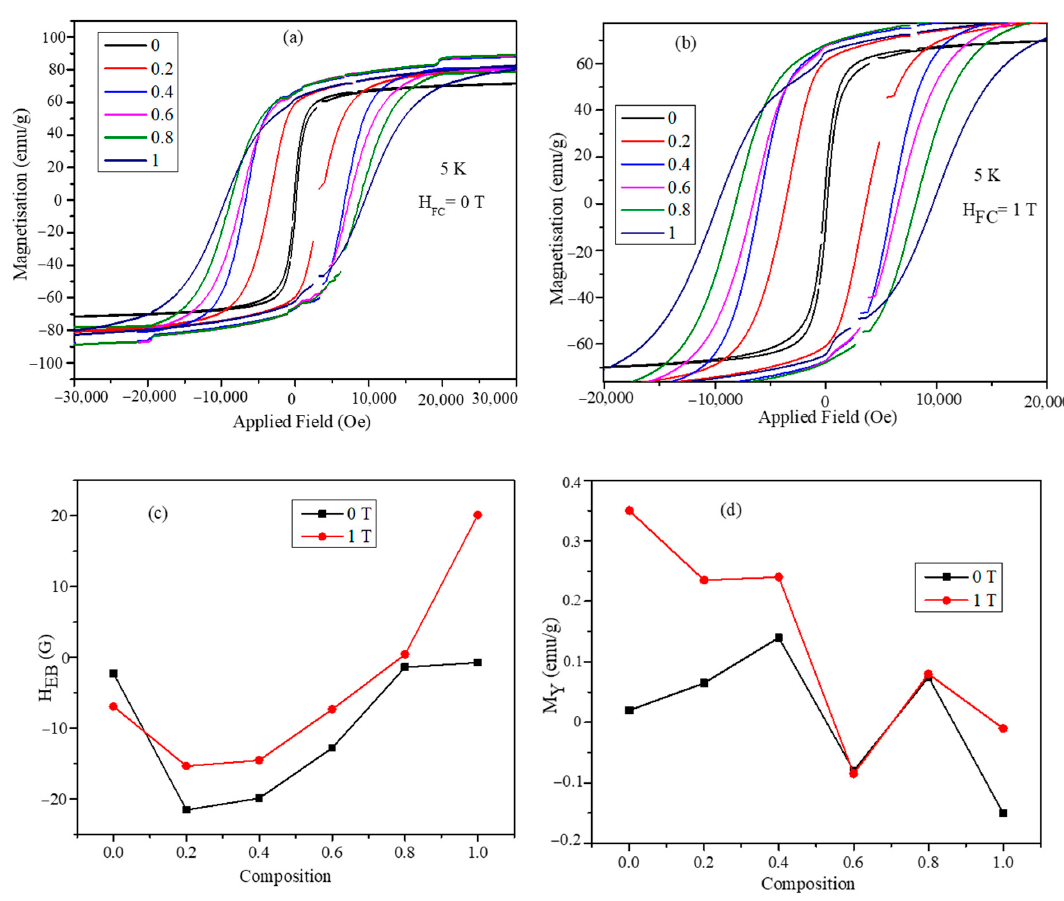
Figure 6. The magnetic hysteresis loops obtained at temperature 5 K ( a ) under zero field cooled (ZFC) condition and ( b ) under 1 T field cooled condition. ( c ) The exchange bias field as a function of composition at temperature 5 K under several field cooled values 0 and 1 T. ( d ) The vertical hysteresis loop shifts as a function of temperature at ZFC and 1 T field cooled conditions (lines in ( c ) and ( d ) are just guides for the eye).